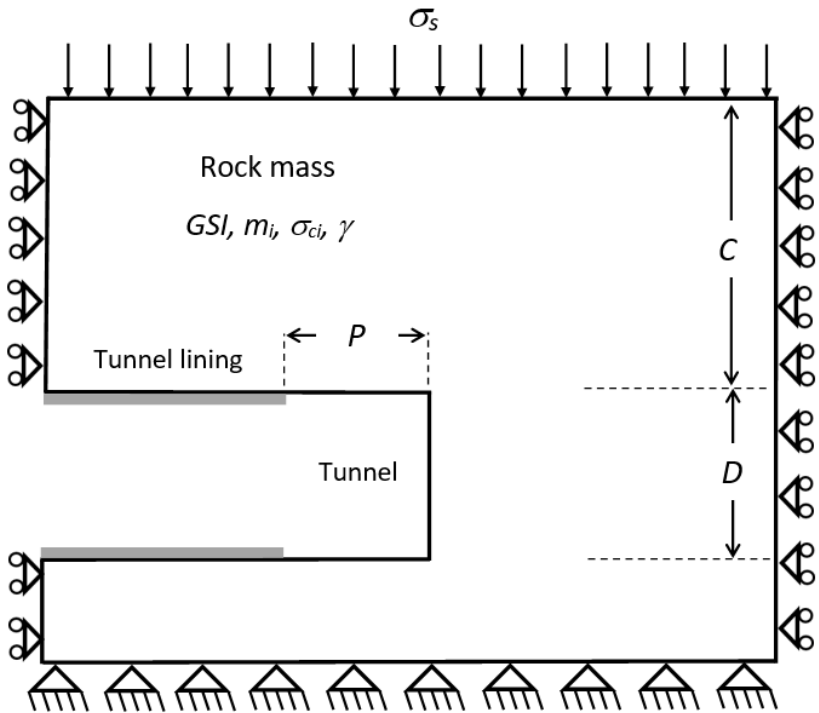
Figure 1. Problem description of a tunnel heading with an unlined length in a rock mass.